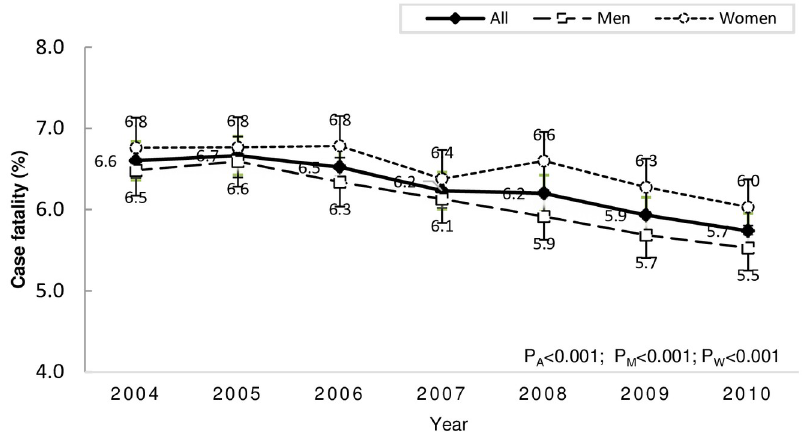
Fig 4. Trends of 1-month case fatality of all strokes. P All = p for trend in all strokes; P M = p for trend in men; P W = p for trend in women.